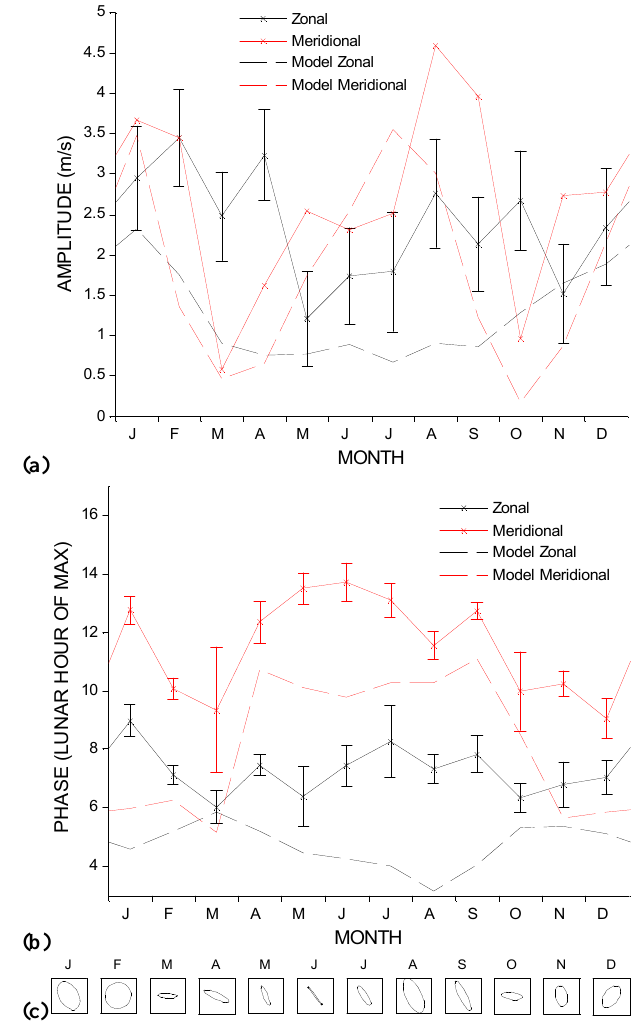
Fig. 1. Monthly-mean amplitudes, phases and hodographs of the Lunar M 2 tide calculated from Ascension Island data (2001–2005) vector averaged to produce the seasonal variation indicated by the solid lines. Dashed lines indicate results from Vial and Forbes (1994) model. Black lines represent the zonal component and red lines the meridional component.